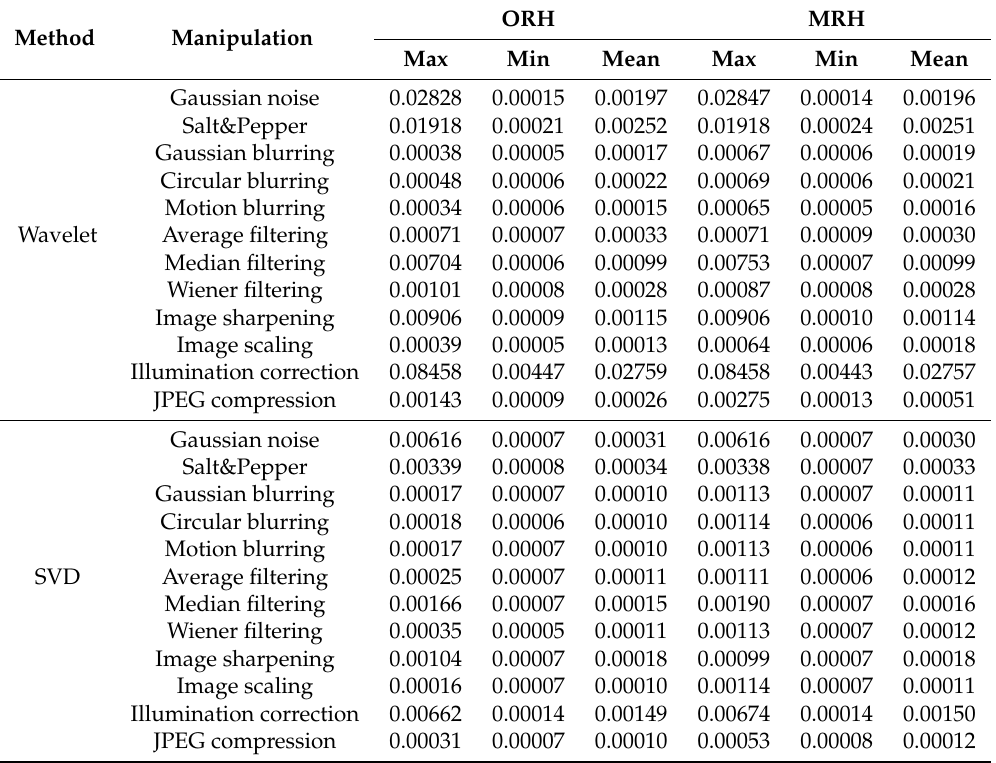
Table 1. Hashing distances under different content-preserving